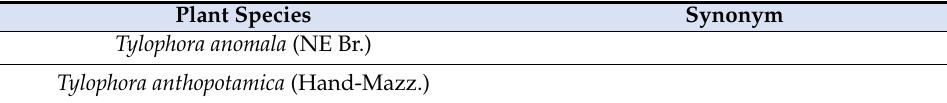
Table 1. List of accepted species in the genus Tylophora and their synonyms. Plant Species